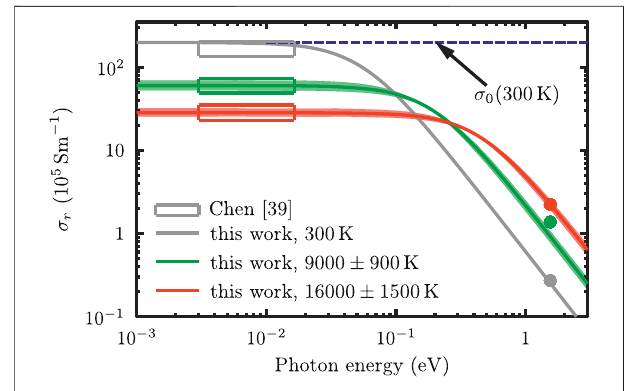
FIGURE 6 | Real part of the broadband electrical conductivity σ r for gold at room temperature (gray line) and at electron temperatures of T e = 9000 ± 900 K (green line) and 16,000 ± 1500 K (red line) according to Eq. 7 . The calculations are compared with THz measurements (triangles) from Ref. [39] and with optical conductivity data from Ref. [29] (full circles). The DC electrical conductivity at room temperature is shown with a blue dashed